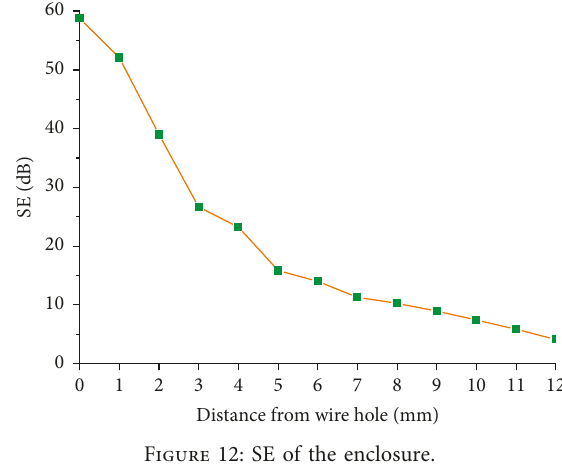
Figure 12: SE of the enclosure.